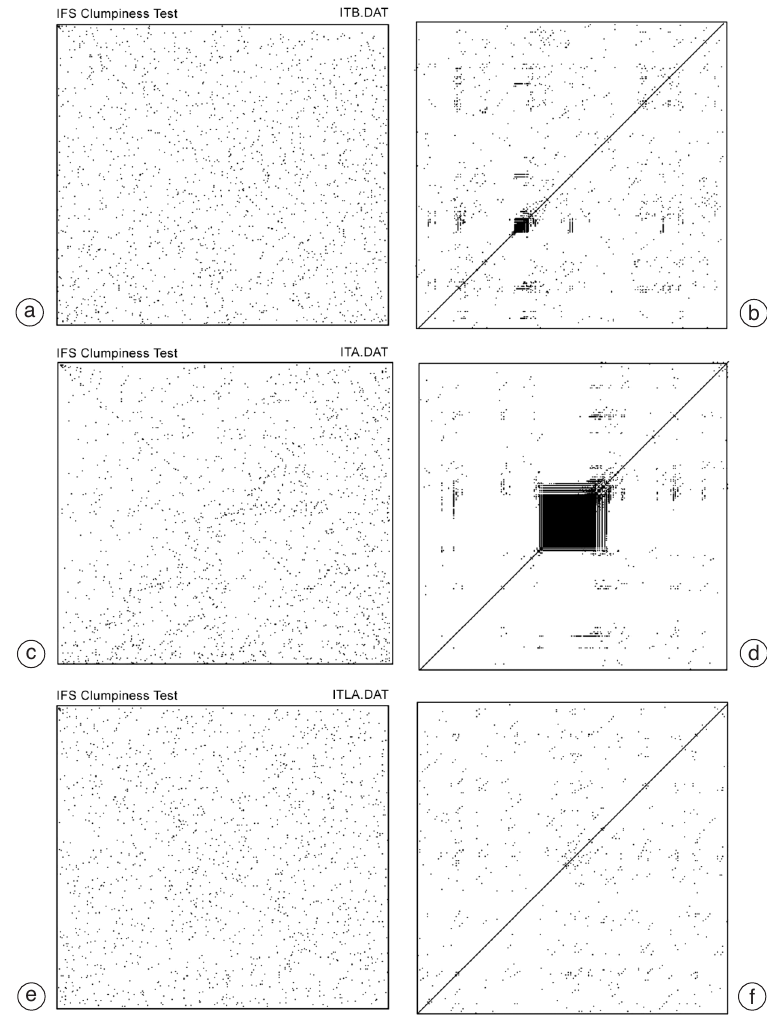
Fig. 2a-f. Qualitative analysis of temporal distribution of earthquakes (complete catalogue, M ≥ 1.7) before the be- ginning of EM experiments (1975-1983), during experiments (1983-1988) and after accomplishing of experiments (1988-1992). IFS-clumpiness test for inter-event time interval sequences: a) before experiments; c) during experi- ments; e) after experiments. Recurrence plots analysis of waiting times sequences: b) before experiments; d) during experiments; f) after experiments. Note diagonal lines in IFS plot and compact structure in RP during